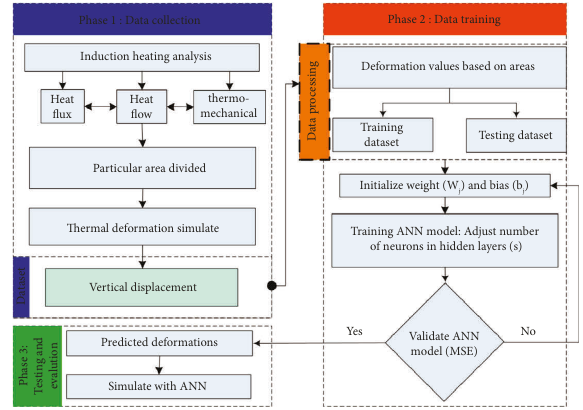
Figure 1: Flowchart of data collection from analysis of induction heating supported with ANN